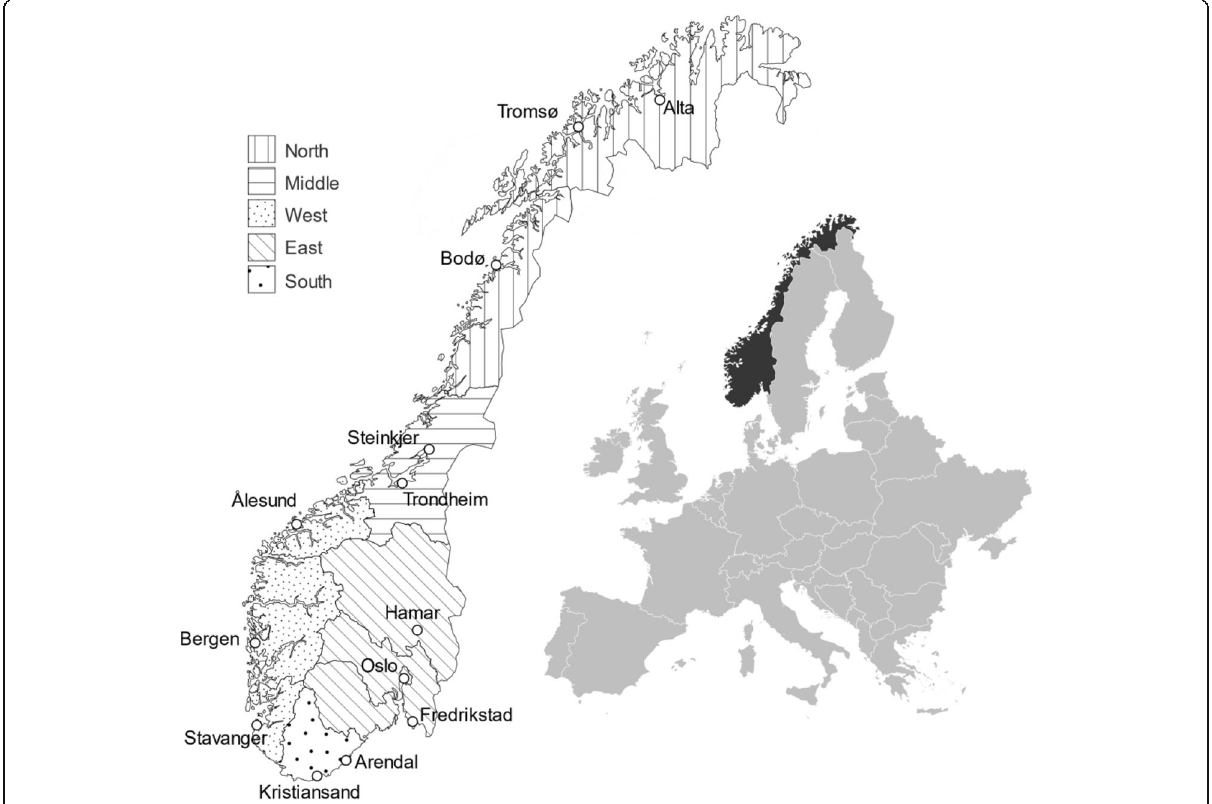
Fig. 1 Map illustrating Norway ’ s location in Europe, the main Norwegian geographical regions and their largest